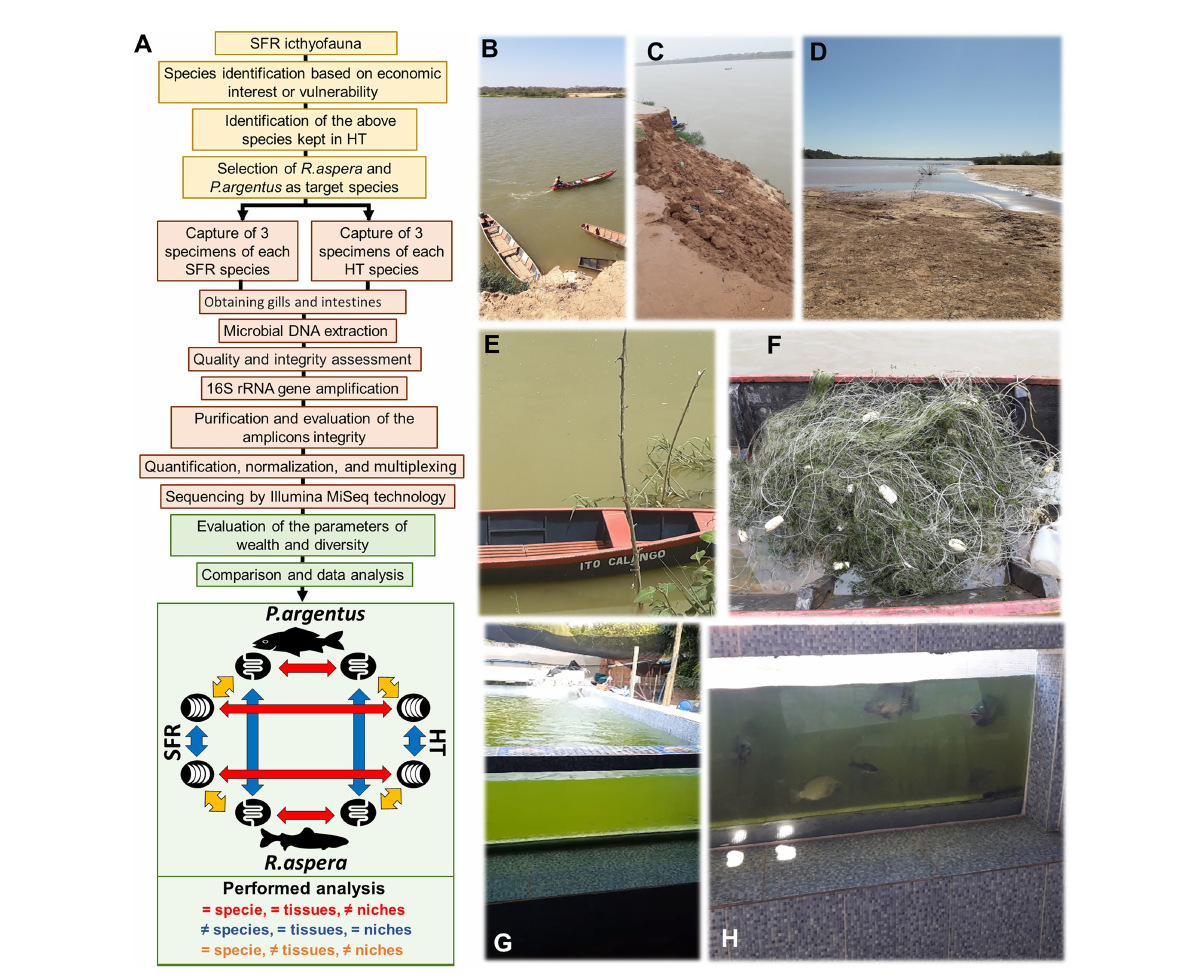
FIGURE 2 (A) Experimental design. The planning steps are on a yellow background, the collection and processing steps on a salmon background, and the steps to obtain results and data analysis on a green background. Photos that, respectively, denote degradation of riparian forests (B) , which causes landslides (C) that in turn contribute to silting up of the SFR bed (D) . (E) Evident eutrophication of the SFR waters at the time of the first collection is best proven when trawls are used (F) . (G,H) HT structure where they were